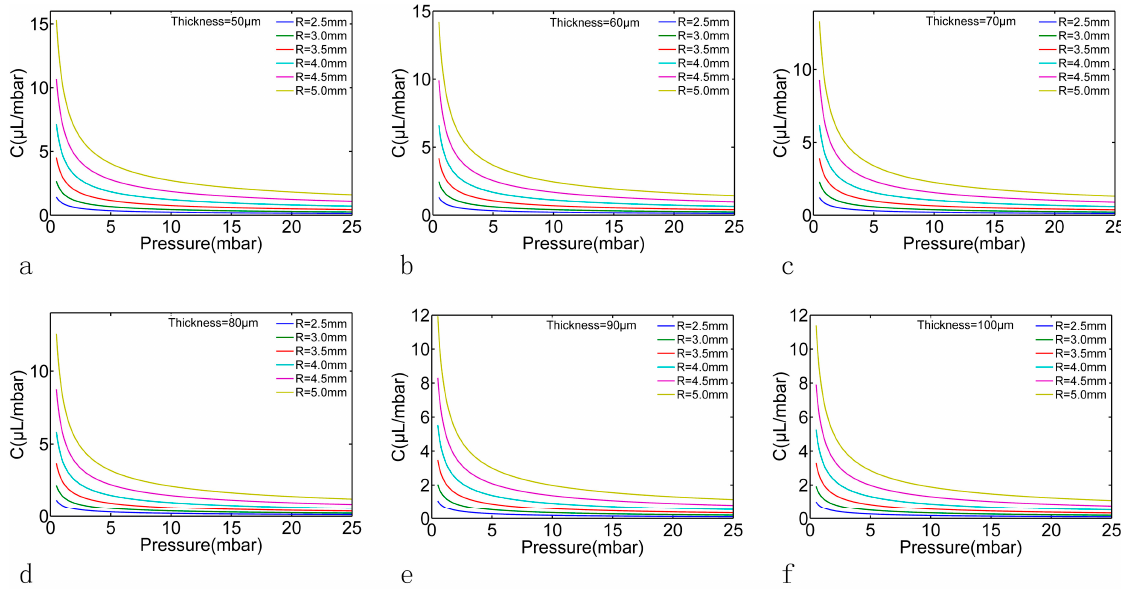
Figure 7. The pressure-capacitance relationships of the PDMS membrane with different radius R and different thickness h derived from the FEM analysis and Equation (8). Subplot ( a – f ) represent the thickness of the PDMS membrane from 50 to 100 µ m with 10 µ m a step.